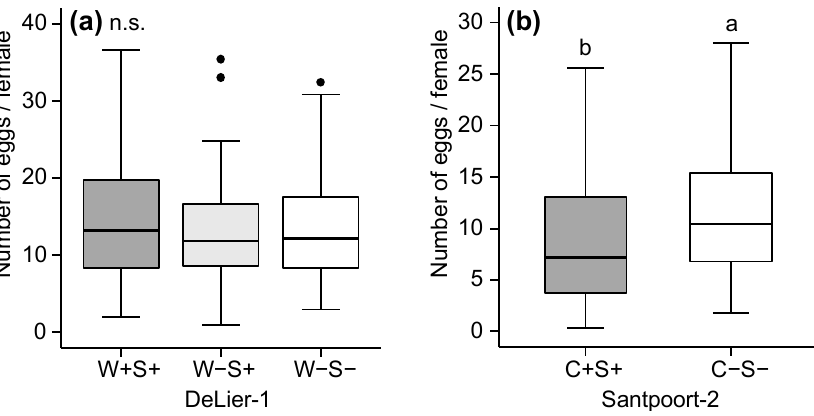
Figure 2. Total number of eggs produced per female in four days in two strains of the spider mite T. urticae which did (+) or did not ( − ) contain Wolbachia (W), Spiroplasma (S) and/or Cardinium (C). ( a ) The DeLier-1 strain with three groups: W+S+, W − S+ and W − S − ; ( b ) The Santpoort-2 strain with two groups: C+S+ and C − S − . Boxes span the 25–75 percentiles, horizontal lines in the boxes represent medians, whiskers span 1.5× interquartile range (IQR), dots represent data points outside of this range. Different letters above the boxes indicate significant differences at a level of p ≤ 0.05, after applying linear mixed models followed by Tukey multiple comparisons with Holm adjustment. n.s.: not